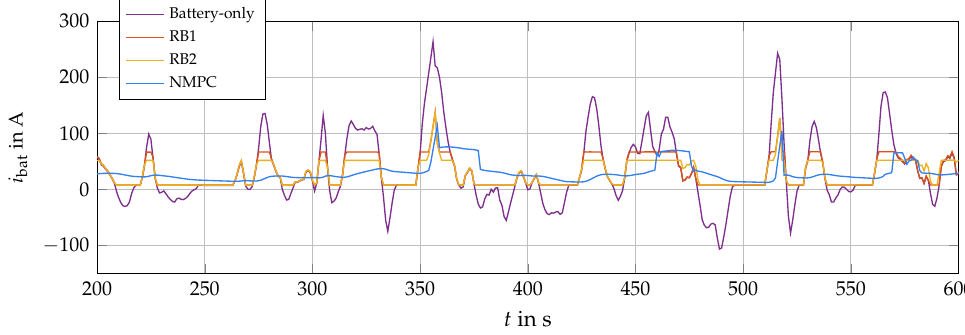
Figure 6. Extract of battery current i bat along the E11 driving cycle for